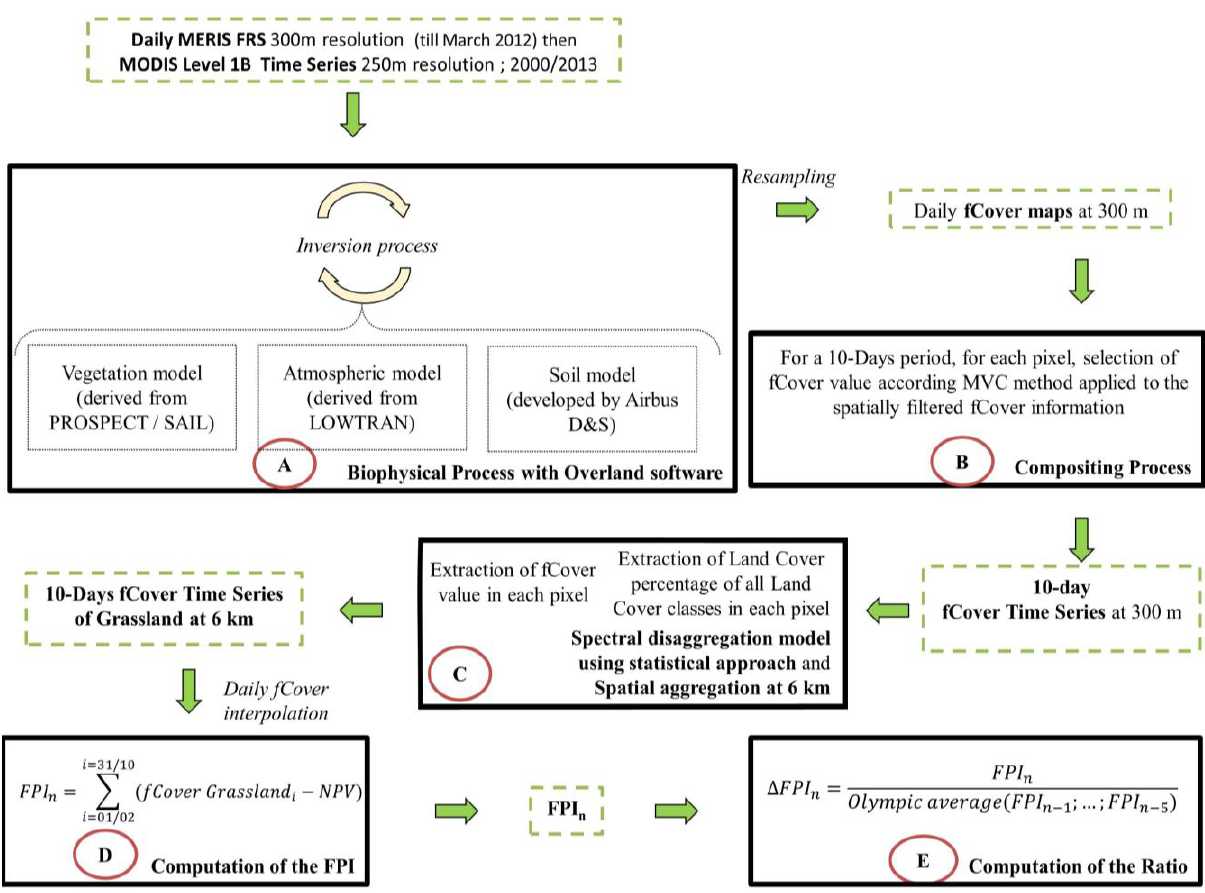
Figure 1. The processing chain of the Forage Production Index (FPI). Rectangles in black bold illustrate the main step of the processing chain. Green dotted rectangles are the intermediate products. PROSPECT = Properties Spectra; SAILn = Scattering by Arbitrarily Inclined Leaves; LOWTRAN = Low Resolution Transmission; D&S = & Space; MVC = Maximum Value Composite; NPV = Non-Productive Vegetation; fCover = Fraction of Green